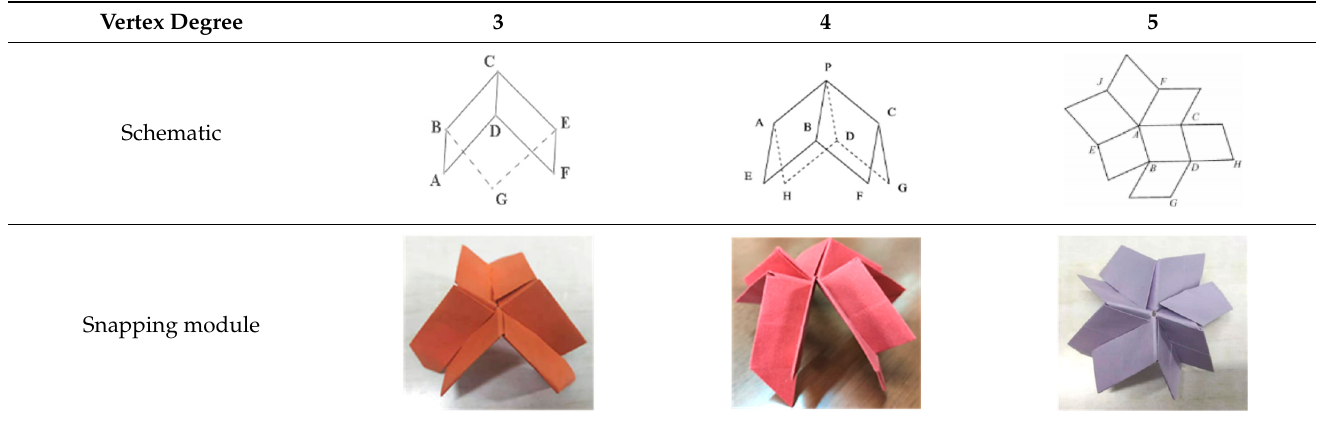
Table 2. Vertex type and snapping